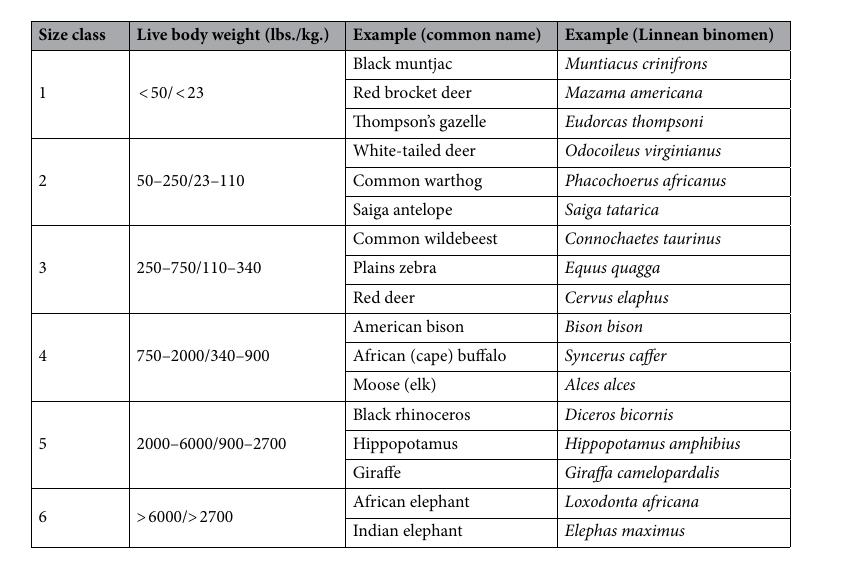
Table 1. Mammal body size classes 56,168